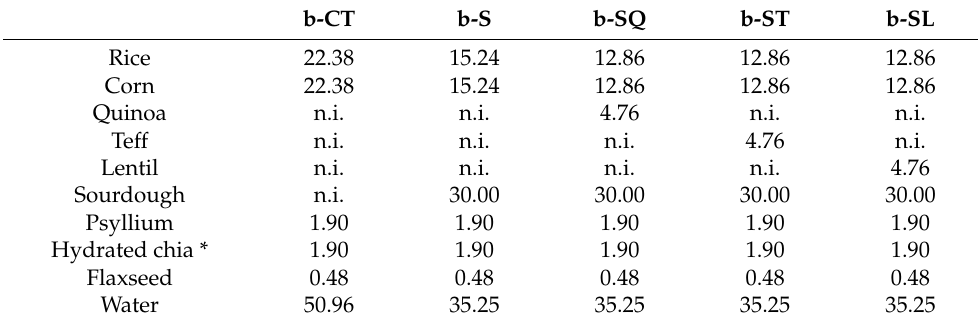
Table 3. Formulations of the experimental breads. Sourdough (DY = 210) was prepared using rice, corn, and chestnut flours (4:4:2). Fermentation by Weissella cibaria P9 at 30 ◦ C lasted 24 h. Baker’s yeast was used at 1.25% ( wt / wt